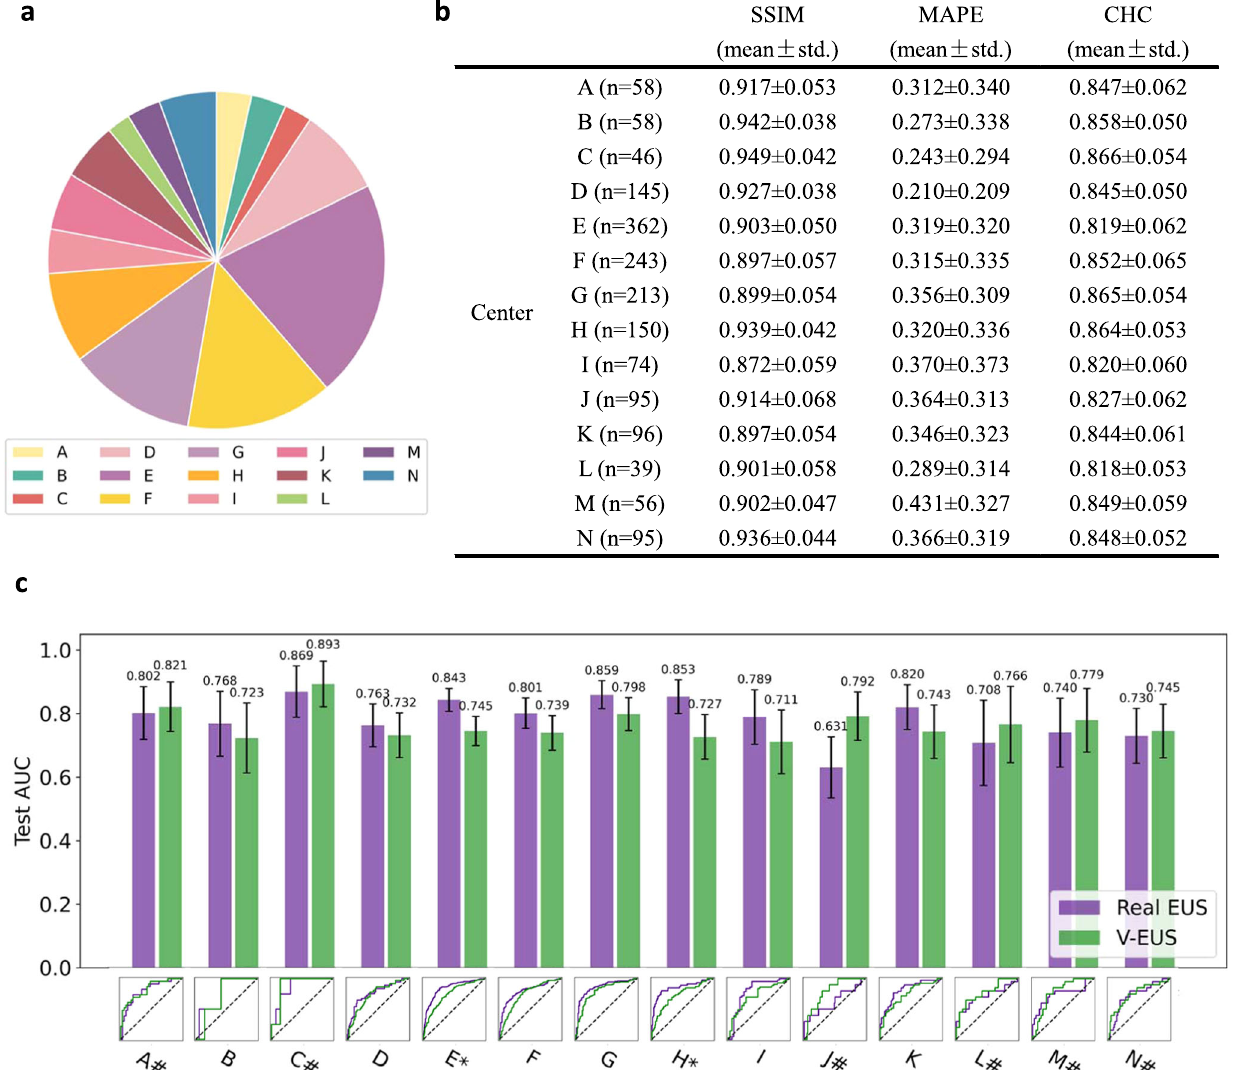
and the p -value for the center H is 0.0055). # indicates that the AUC of V-EUS is greater than that of real EUS. Error bar indicates 95% con fi dence intervals of AUC. Source data are provided as a Source Data fi